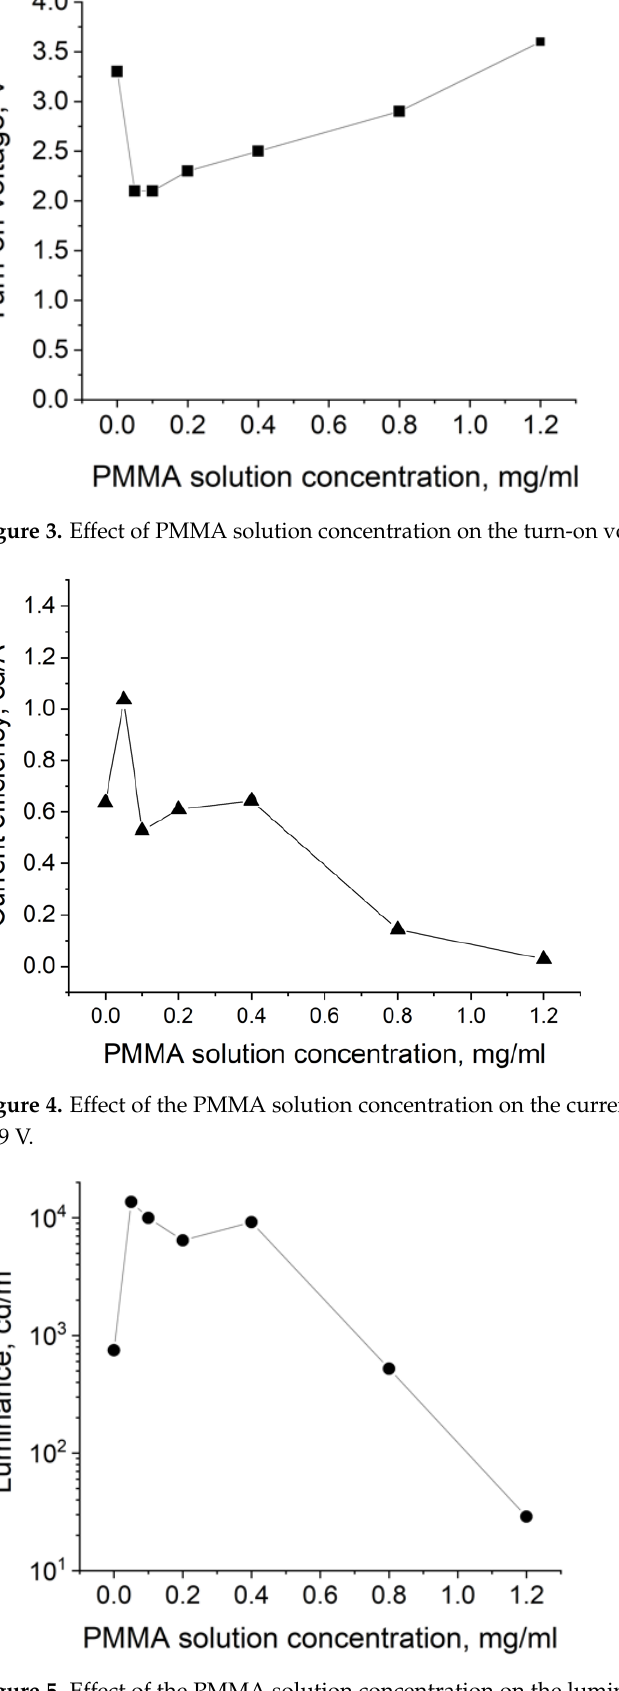
Figure 5. Effect of the PMMA solution concentration on the luminance of the QDLED device at 9 V.